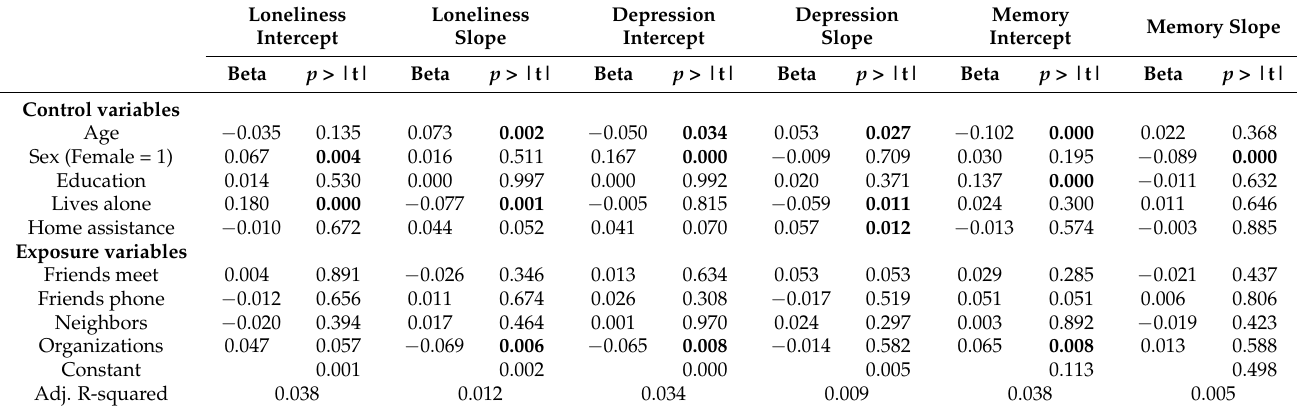
Table 3. Regression analysis on outcome variables among individuals in Profile 1 (best outcomes). n = 1969.